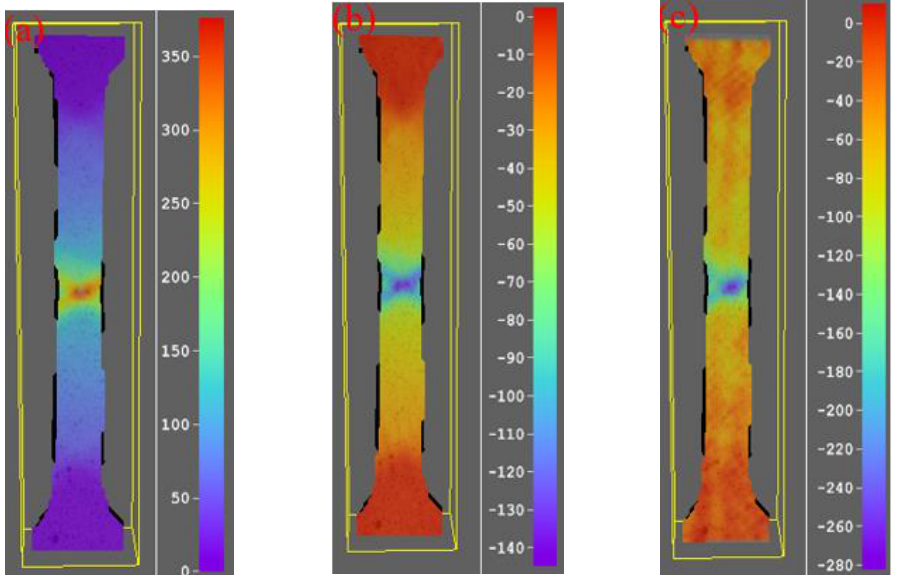
Figure 11. Full field strain distribution of sample surface measured by DIC system: ( a ) distribution of length strain; ( b ) distribution of width strain; ( c ) distribution of thickness strain.